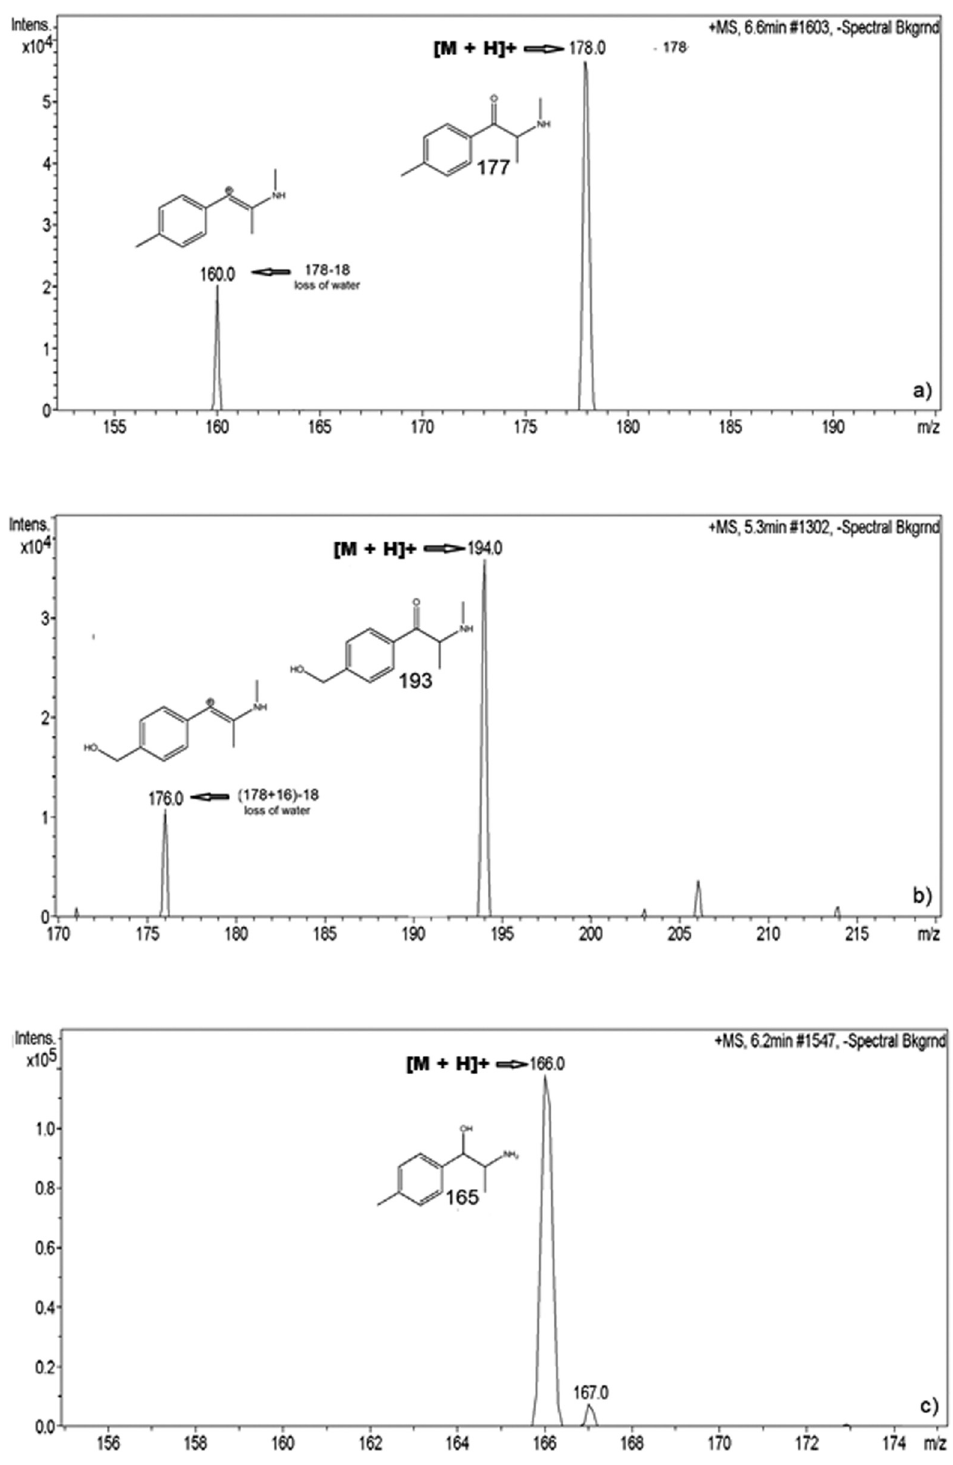
Figure 2: LC - MS data of ( a ) mephedrone and ( b ) a metabolite produced by in vitro metabolism of mephedrone, in the hydroxylation step: hydroxytoly - mephedrone. It also presents ( c ) a metabolite produced by a two - step process of reduction and demethylation: nor - 4 × 10 − 2 to 16 mM. The collected data, i.e. about the per - were considered as having zero percentage cell death. centage of cell death, were normalized, where the blanks The potency of the drug to cause the e ff ect is evaluated